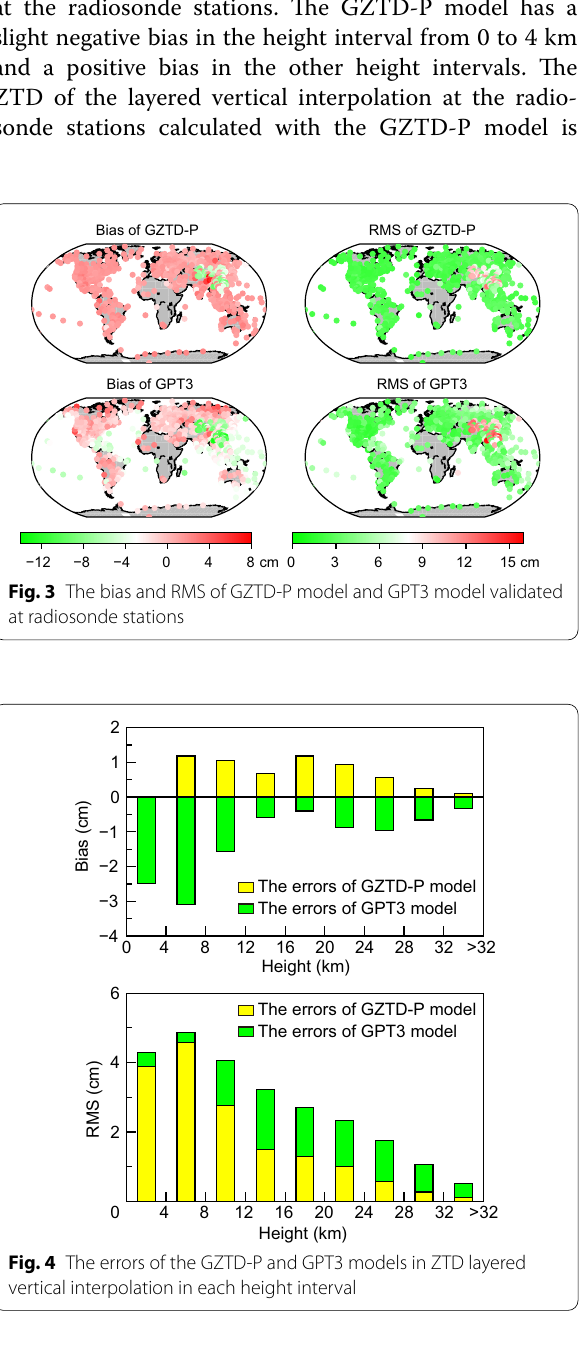
Fig. 4 The errors of the GZTD-P and GPT3 models in ZTD layered vertical interpolation in each height